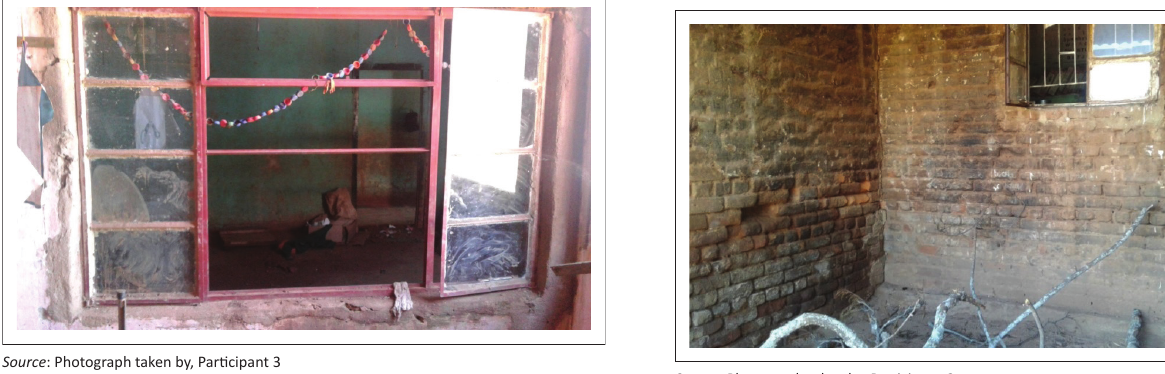
Source : Photograph taken by, Participant 6 FIGURE 3: Learning classroom with firewood inside, exposing learners to scorpions.